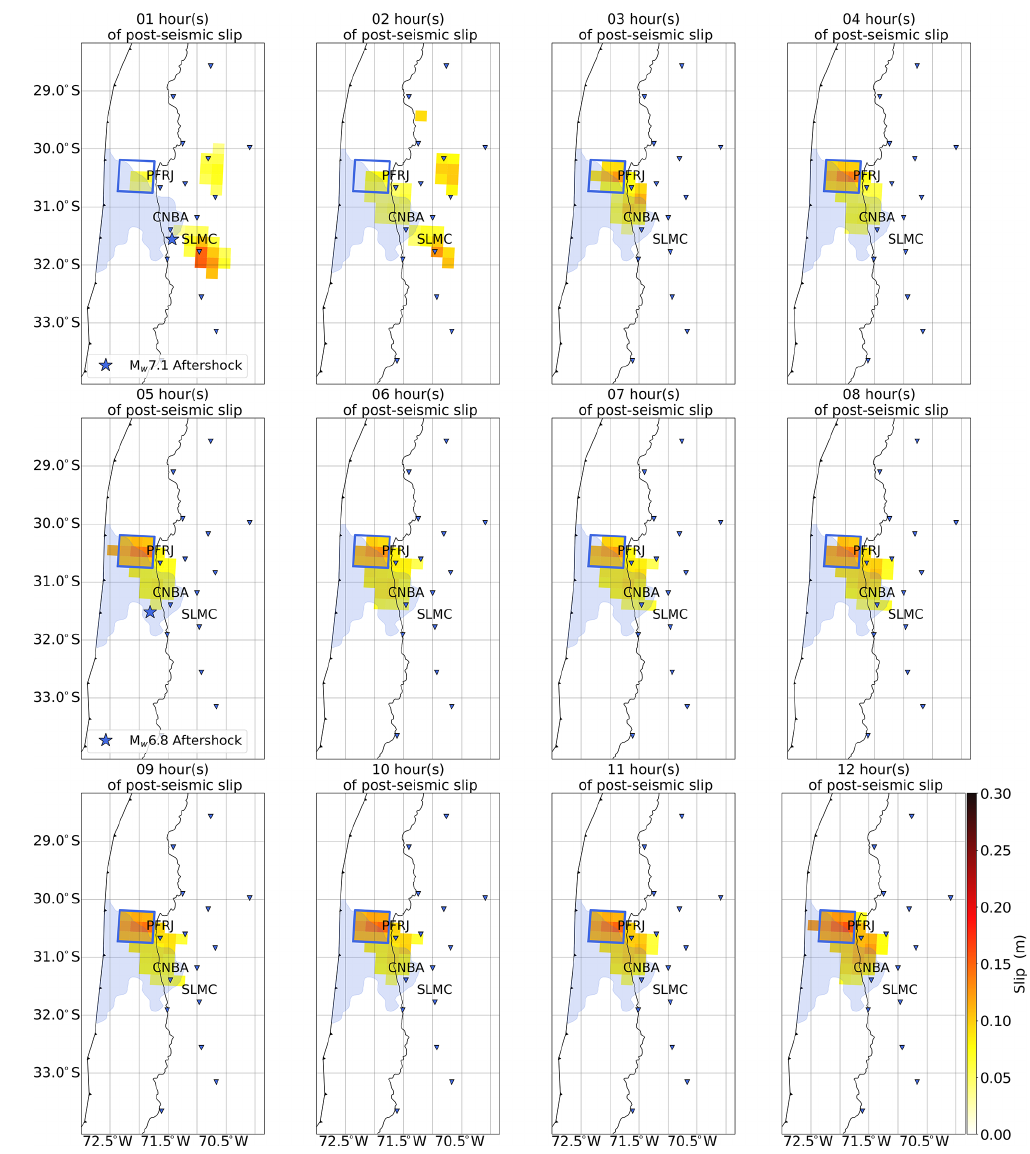
Figure 7. This is the same as Fig. 3 except that these hourly images have been obtained after removing the two largest aftershocks from the position time series. The blue square outlines what we refer to as the northern